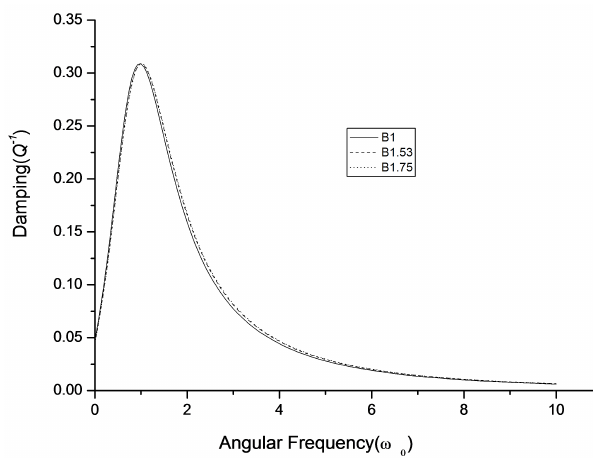
Figure 4: Variation in damping with respect to angular frequency ( α = 0.25) .